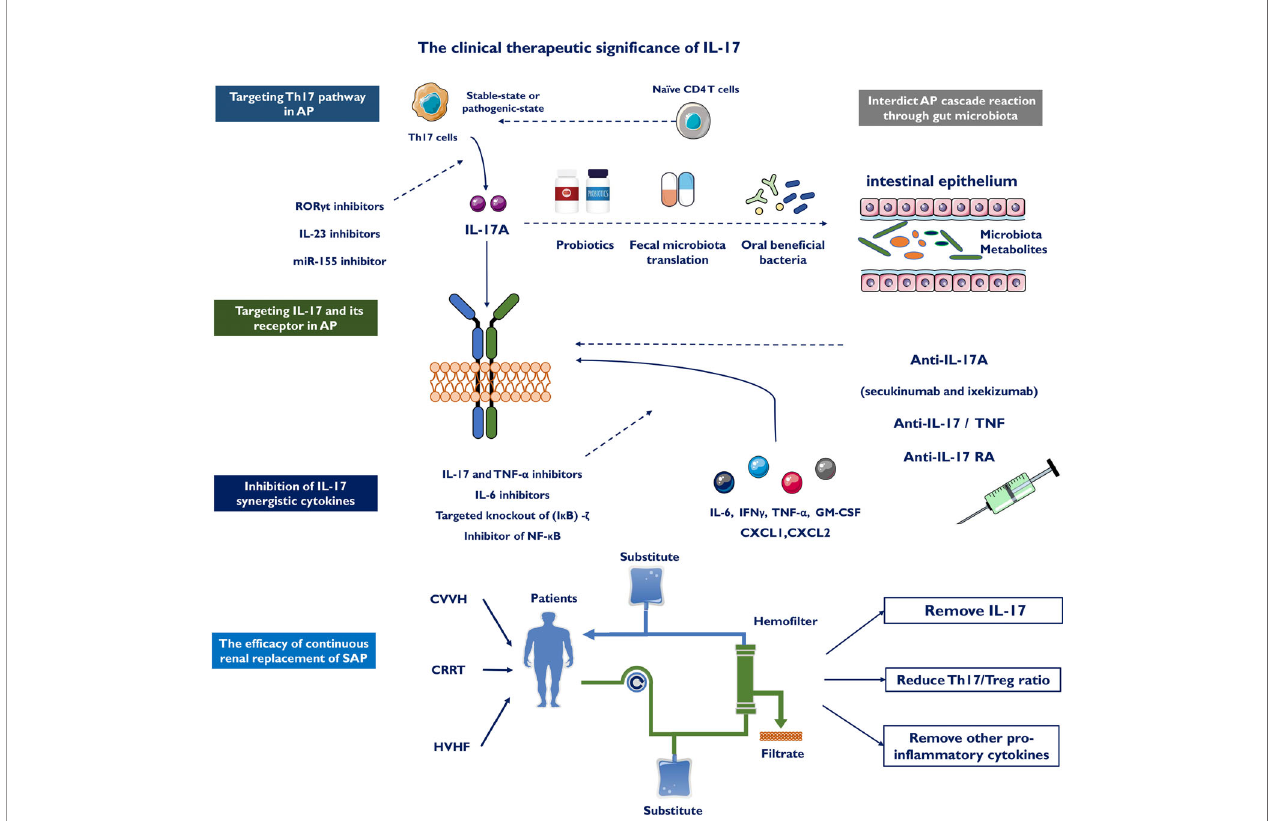
FIGURE 4 | The clinical therapeutic signi fi cance of IL-17. IL-17 could boost deeper comprehend of AP and represents a novel immunotherapy for AP by targeting the Th 17 cell/IL-17 immune axis, including targeting Th17 pathway in AP, targeting IL-17 and its receptor in AP, inhibition of IL-17 synergistic cytokines and interdicting AP cascade reaction through gut microbiota. Continuous renal replacement therapy (CRRT), continuous veno-venous hemo fi ltration (CVVH) and high- volume hemo fi ltration (HVHF) effectively attenuates the Th17/Treg imbalance and clear serum IL-17 in SAP